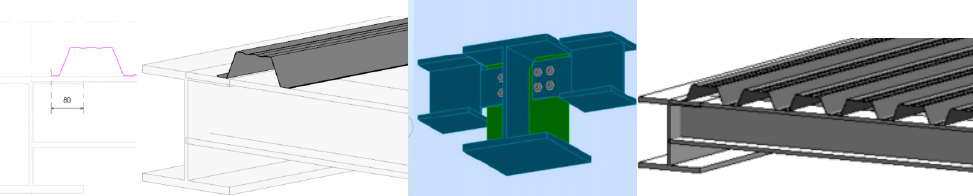
Figure 34. ( a ) The lateral upper floor was replaced by a composite slab. ( b ) Model with the new structure.